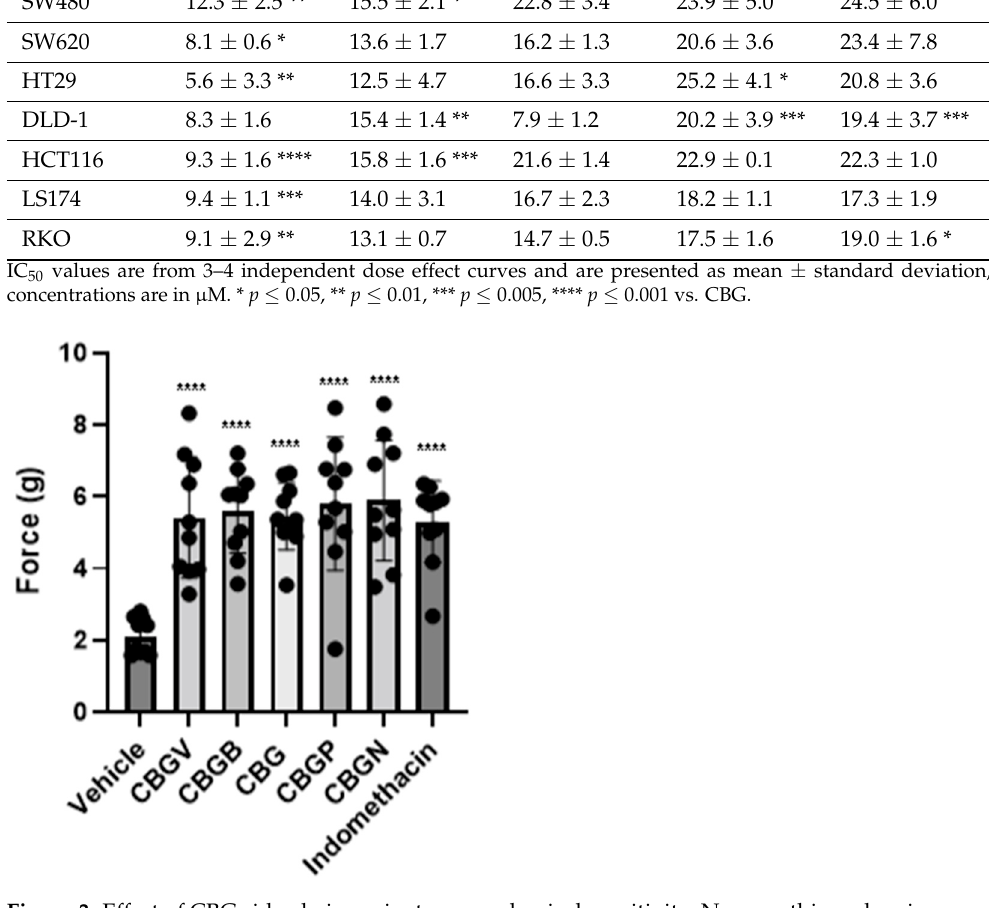
Figure 3. Effect of CBG side-chain variants on mechanical sensitivity. Neuropathic male mice were treated with 10 mg/kg of vehicle, side-chain variant of CBG, or indomethacin as a positive control and mechanical sensitivity was assessed using von Frey filaments. n = 10 mice per group, **** p ≤ 0.0001.